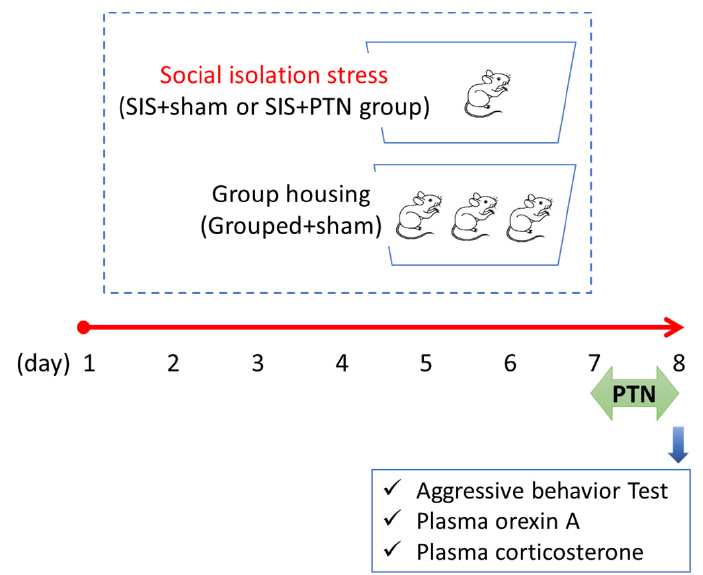
Figure 2. Protocol of the social isolation stress experiment. Rats in the SIS groups were individually housed for eight days. On day 8, the aggressive behavior test was performed, and plasma levels of orexin A and corticosterone were measured. PTN, press tack needle; SIS, social isolation stress.